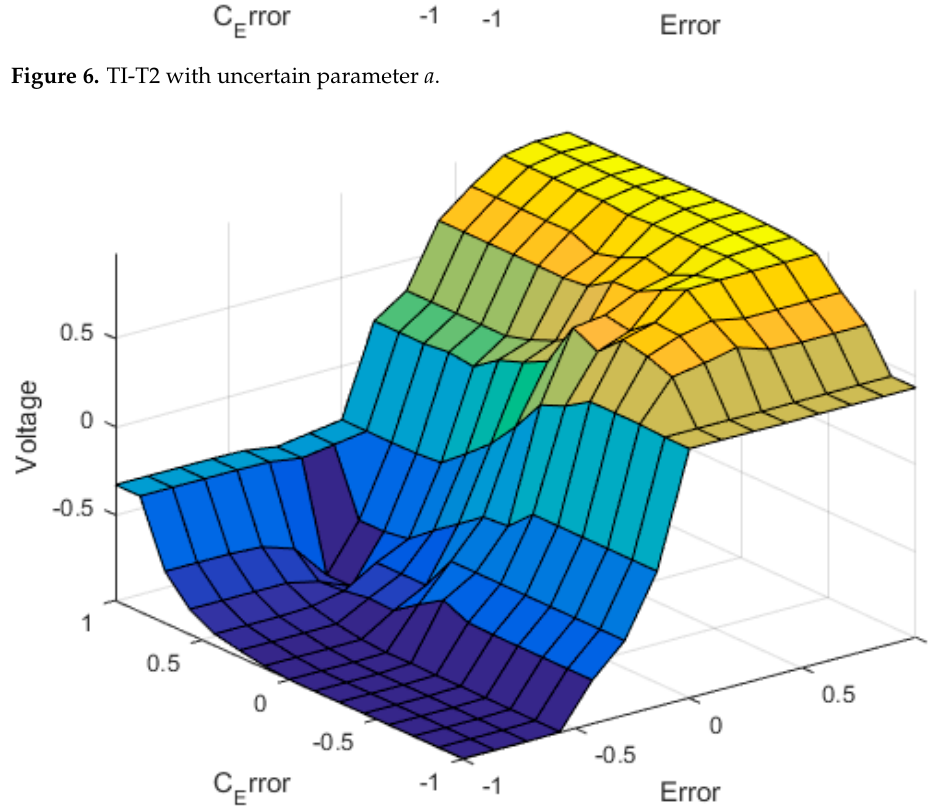
Figure 5. DC motor surface controller. Figure 7. TI-T2 with uncertain parameter a Figure 6. IT-T2 with uncertain parameter 𝑎 .